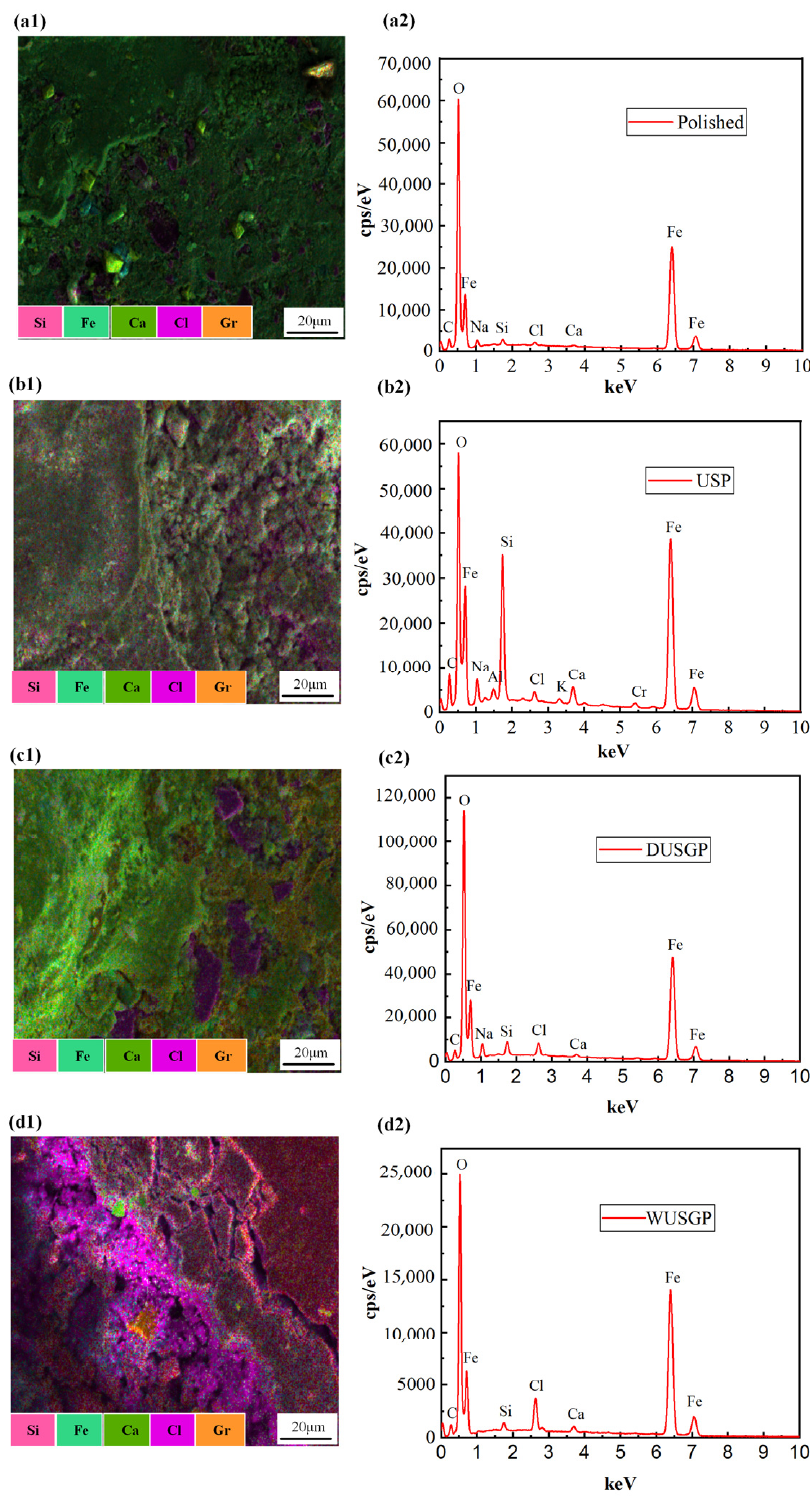
Figure 10. ( a1 , a2 ) are the surface element distribution and content of Sample polished, respectively; ( b1 , b2 ) are the surface element distribution and content of Sample USP, respectively; ( c1 , c2 ) are the surface element distribution and content of Sample DUSGP, respectively; ( d1 , d2 ) are the surface element distribution and content of Sample WUSGP, respectively. Table 4. Element atomic fraction of corrosion product in crack area of samples.